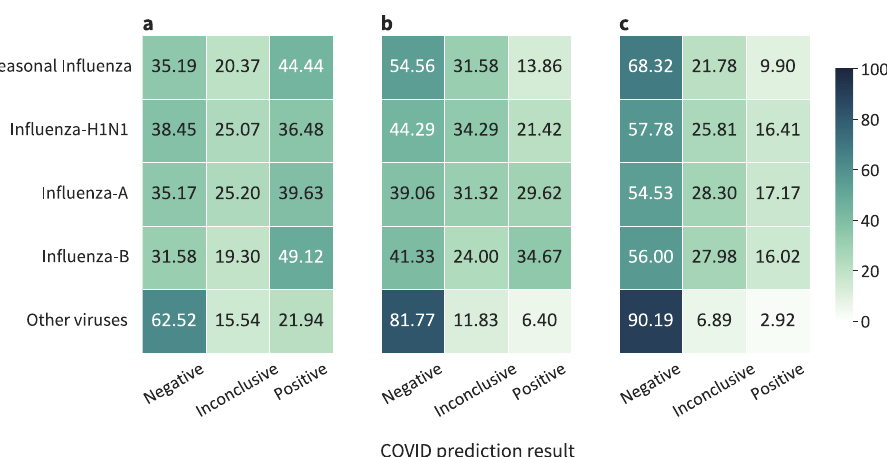
Fig. 5 Results of different models evaluated on 2019 individuals with con fi rmed RT-PCR results for diverse viruses, including In fl uenza-A, In fl uenza-B, In fl uenza-H1N1, and Seasonal In fl uenza. a Model trained only on SARS-Cov-2 data. CBC ( − ) includes only COVID-19 ( − ). b Model trained using data of diverse viruses, including SARS-Cov-2. CBC ( − ) also includes viruses other than SARS-Cov-2. c The stacked model. CBC ( − ) also includes viruses other than SARS-Cov-2. Specialized models are trained using half of the training sets, and then these specialized models are combined using the other half of the training sets. N = 11 116 CBCs.